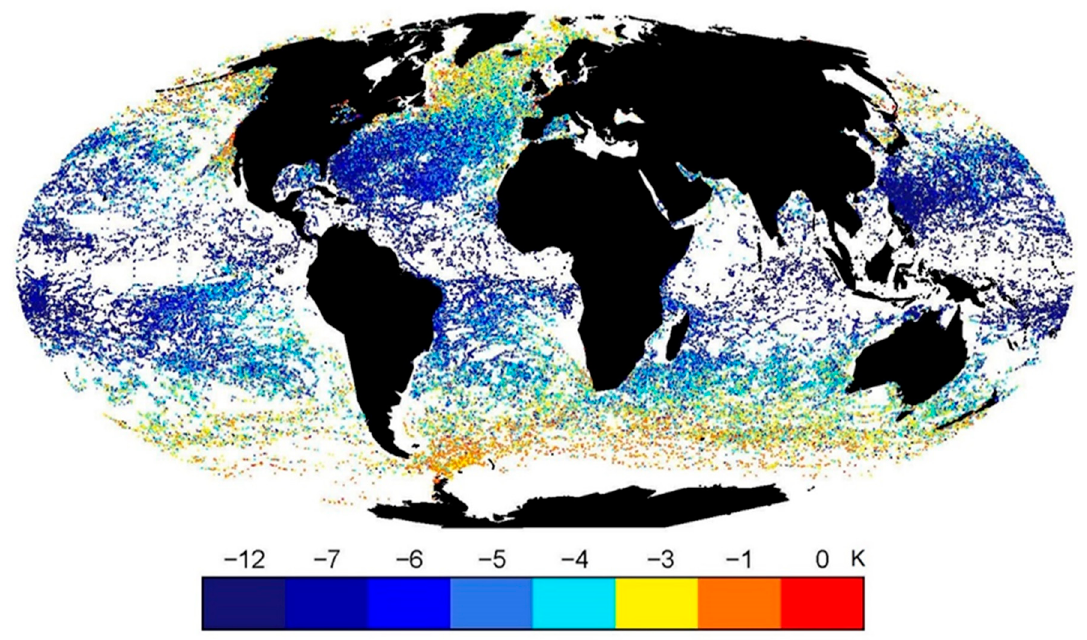
Figure 4. Distribution of VIIRS-buoy matchups for the period January 2012 to September 2013. Note the absence of matchups in many equatorial regions, high latitudes, major upwelling areas, and in the western Indian Ocean. Matchups in much of the Equatorial Pacific Ocean are limited to those with moored buoys, indicated by the linear arrays of dots at the mooring positions. These are nighttime, clear sky matchups, and the colors indicate the difference between the VIIRS top-of-atmosphere brightness temperatures measured in the 11 µ m channel (VIIRS band M15) and the subsurface buoy temperature measurements, in K. The temperature difference is largely caused by the effects of the intervening clear atmosphere reducing the radiance measured by VIIRS at orbital height, and the correction of these effects is the purpose of the atmospheric correction algorithms (see Section 4.2. below).